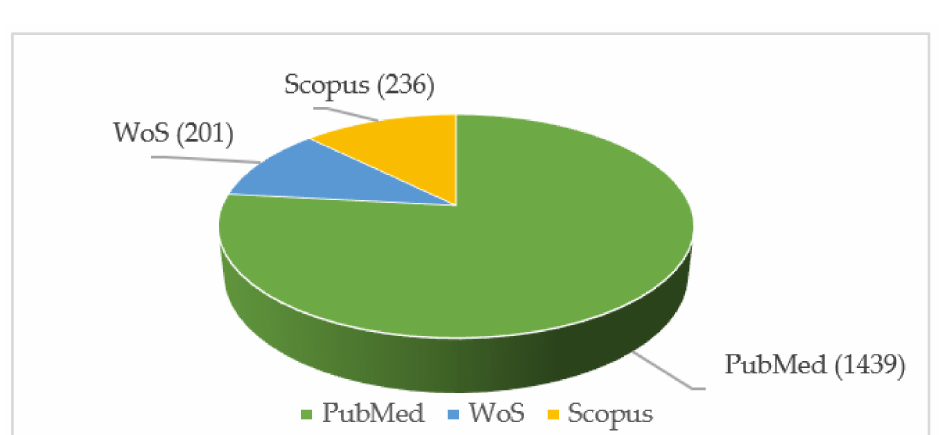
Figure 1. Document distribution of each